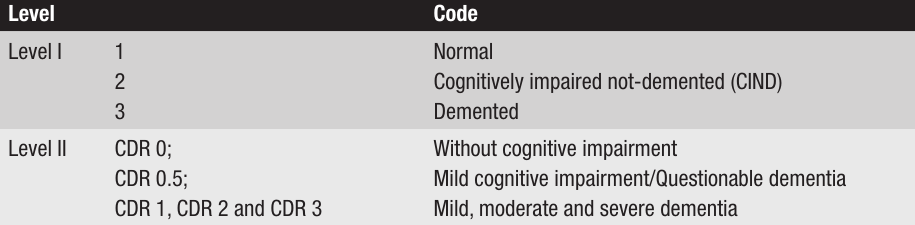
Figure 2. Levels of comparison at which diagnosis were defined.